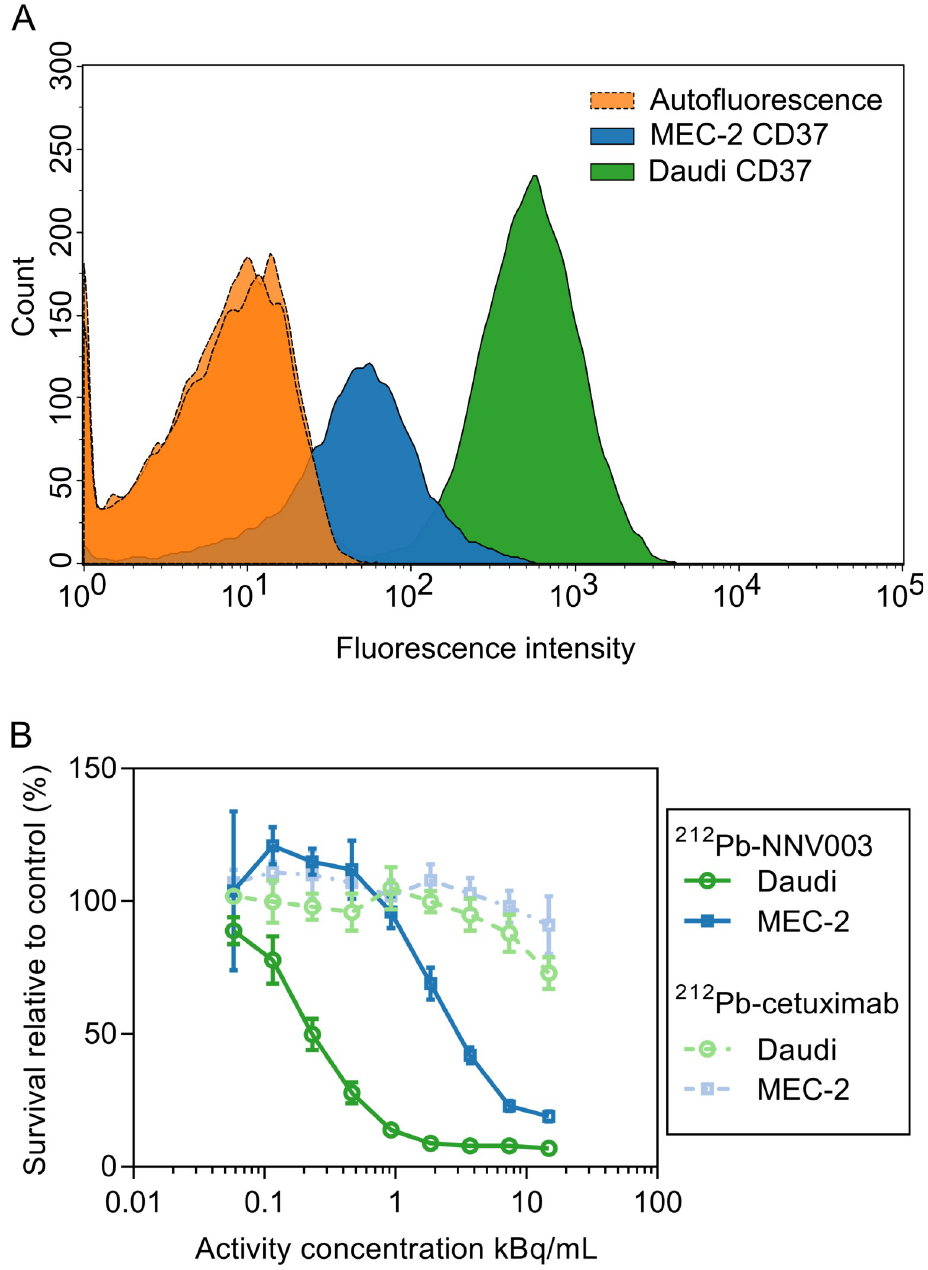
Fig 1. CD37 expression and cytotoxic effect of 212 Pb-NNV003. (A) Flow cytometry histograms of cells only and cells incubated with 5 μ l Alexa Fluor 1 647 anti-human CD37. (B) Proliferation of Daudi and MEC-2 cells treated with 212 Pb-NNV003 or 212 Pb-cetuximab. Data represented as average of n = 8 replicates and error bars = SD. severely toxic doses (HNSTD) were established: 185 kBq in CB17 SCID mice and 555 kBq in R2G2 mice, and the following 212 Pb-NNV003 doses were chosen for therapy studies: 90, 185 and 280 kBq (CB17 SCID) and 185, 370, 555 and 740 kBq (R2G2). The two additional doses of 280 kBq (CB17 SCID) and 740 kBq (R2G2) that were not tested in the acute toxicity studies were included to test the range of the therapeutic window.